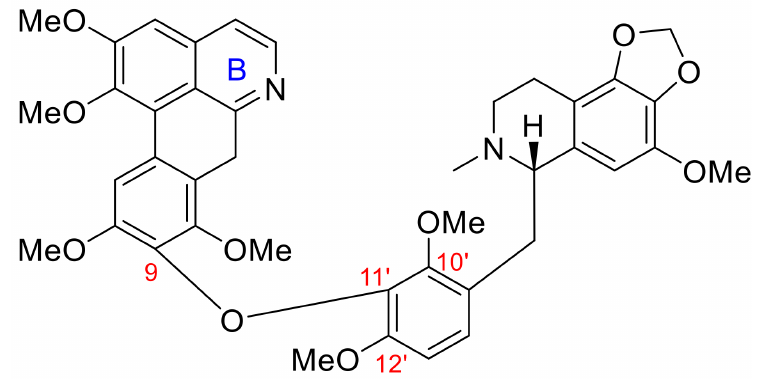
Figure 10. Structure of (+)-przewaline ( 115